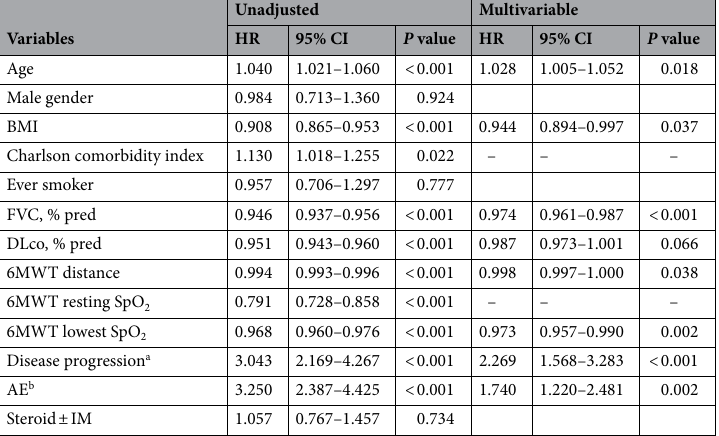
Table 3. Prognostic factors for overall mortality in patients with IPF assessed by using Cox regression analysis. IPF idiopathic pulmonary fibrosis, HR hazard ratio, CI confidence interval, BMI body mass index, FVC forced vital capacity, DLco diffuse lung capacity of carbon monoxide, 6MWT 6-min walk test, SpO 2 saturation of pulse oximetry, AE acute exacerbation, IM immunosuppressant. a Disease progression was defined as 10% relative decline in FVC for 6 months. b AE was compared to no respiratory deterioration in Cox regression analysis.